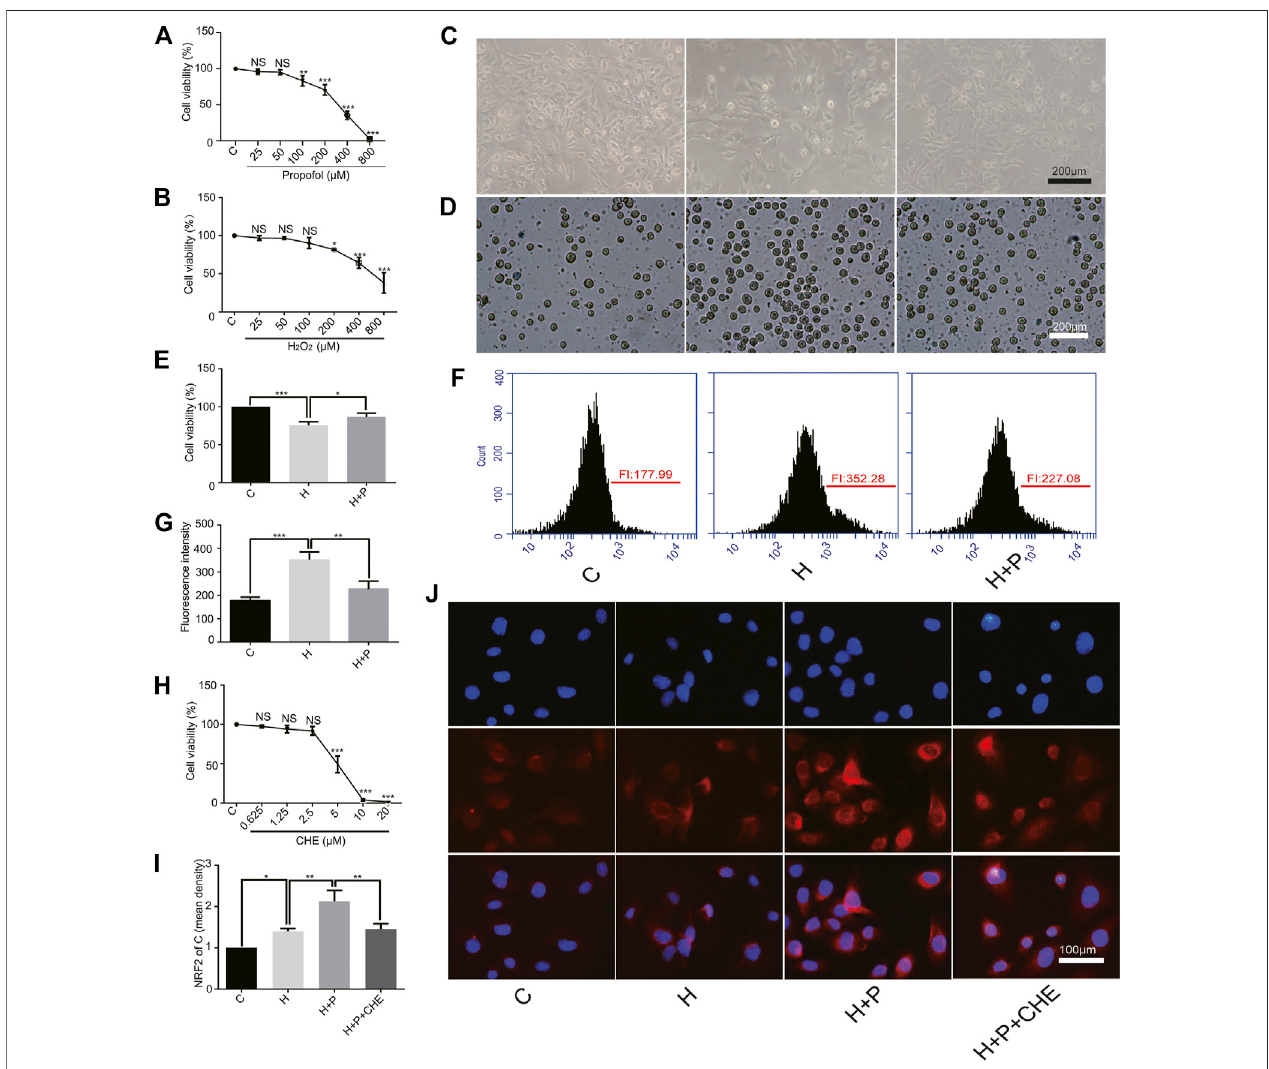
FIGURE 3 | Effect of propofol on H 2 O 2 -induced H9C2 cells injury. Cell viability of H9C2 cells treated with H 2 O 2 (H, 0 ∼ 800 μ M) (A) and propofol (P, 0 ∼ 800 μ M) (B) . (C – E) : Effect of propofol on H 2 O 2 -induced cell deaths. Dead cells were stained with blue by trypan blue. Scale bar: 200 μ m. (F) and (G) : Effect of propofol on H 2 O 2 - induced ROS production. Quanti fi cation of ROS is expressed as the fl uorescence intensity (FI). (H) . Viability of H9C2 cells treated with chelerythrine (CHE, 0 ∼ 20 µM). (I,J) . Expression of NRF2 in the H9C2 cells based on the immuno fl uorescence assay. The scale bar is 100 µM. N (cid:1) 3. Data are expressed as the mean ± SD. Signi fi cance was calculated using the ANOVA and p < 0.05 was considered statistically signi fi cant. * p < 0.05, ** p < 0.01, *** p < 0.001.